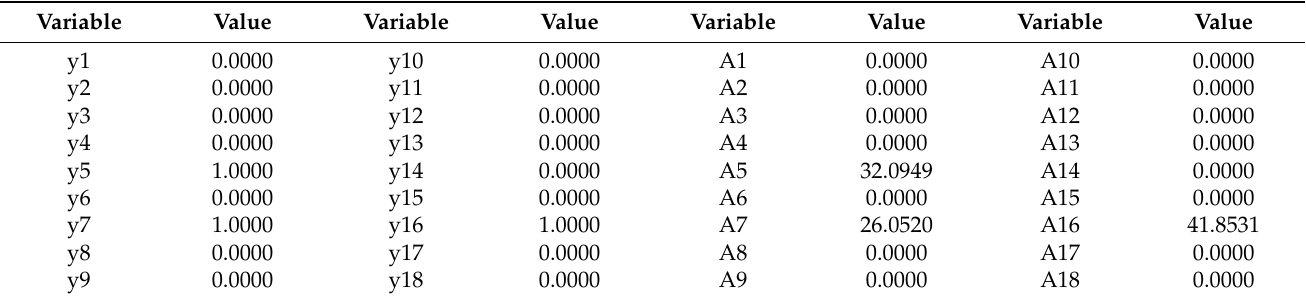
Table 6. The investment portfolio design results with LSTM and the VaR.